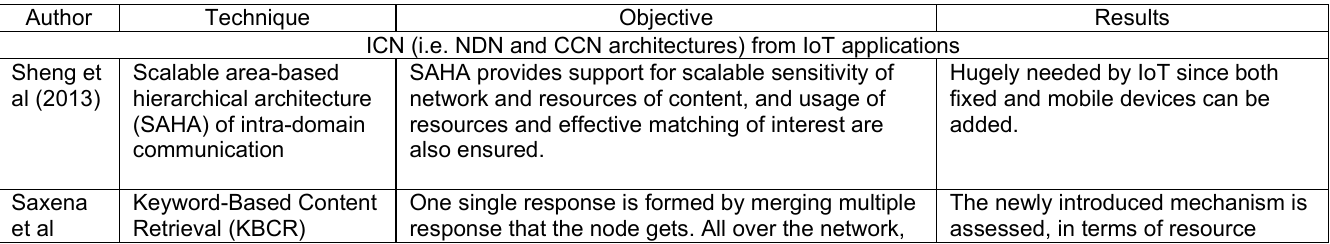
Table 1. Comparison of Available